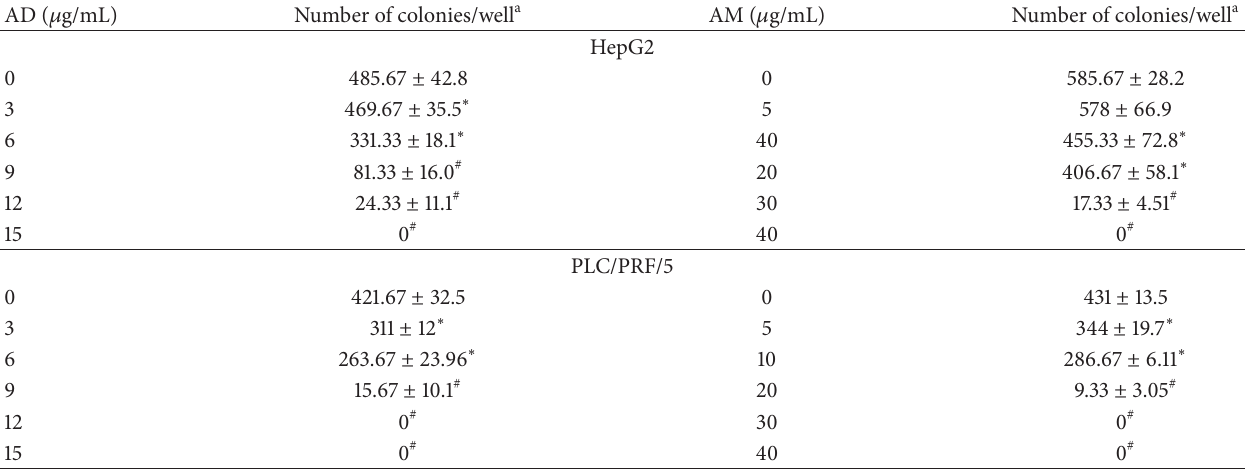
a Data are given as mean ± SD from three independent experiments. ∗ 𝑃 < 0.05 indicates significant difference from the untreated control. # 𝑃 < 0.01 indicates significant difference from the untreated control.